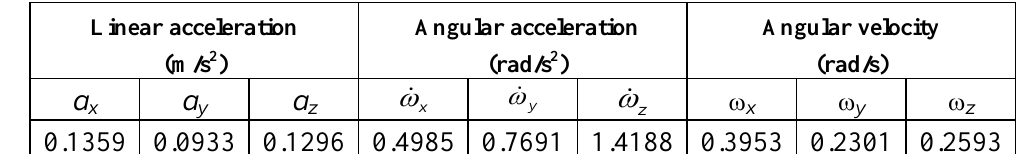
Table 1. The RMSE Between the traditional IMU and the 12-axis IMU while the apparatus moved arbitrarily in the 3-dimensional space.